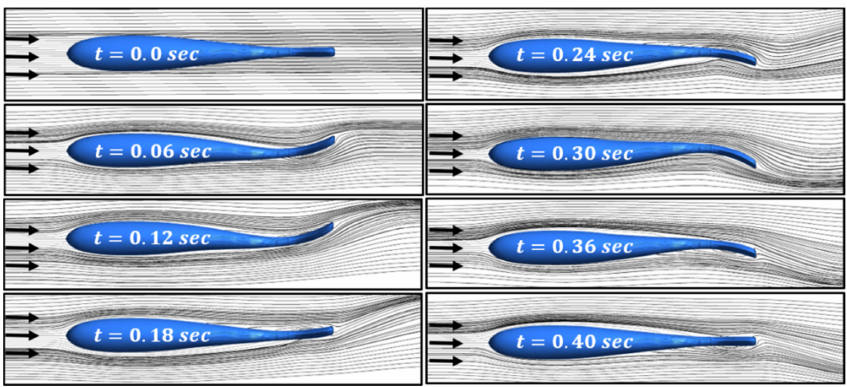
Figure 5. Instantaneous streamlines on the tank mid-plane (2.5